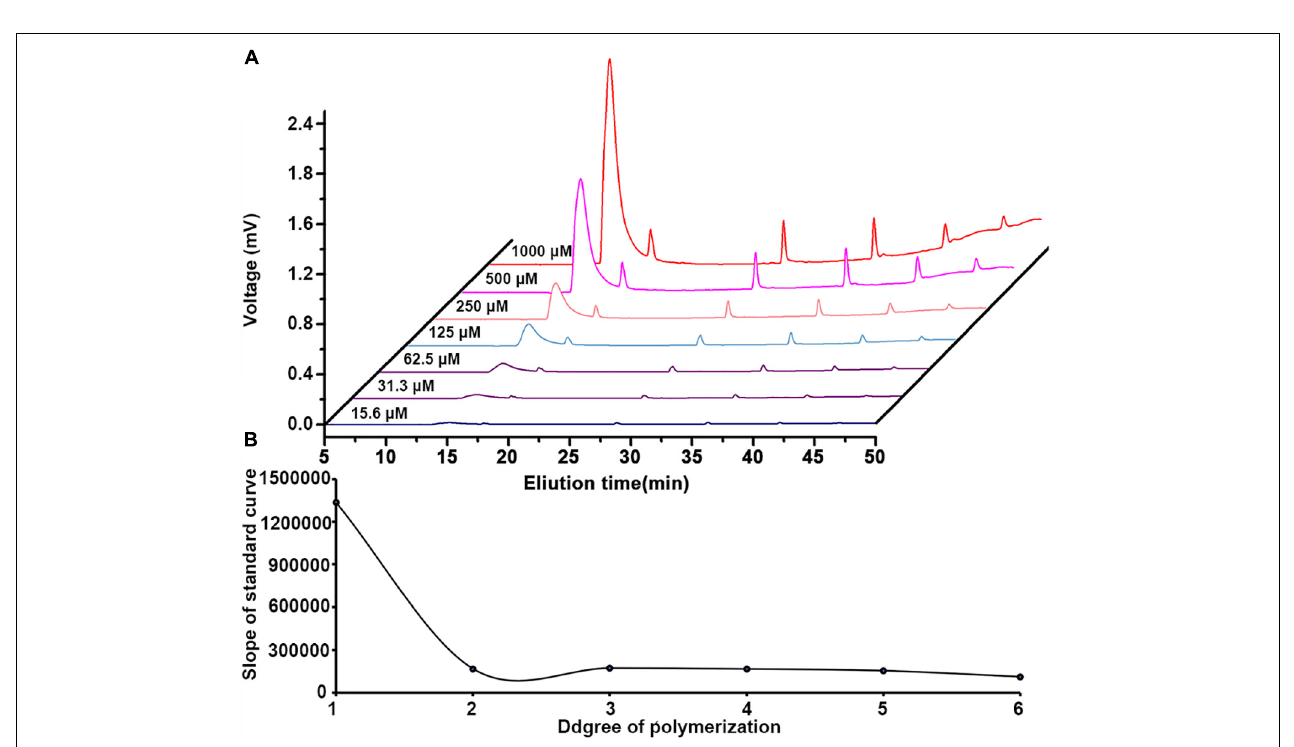
FIGURE 5 | (A) HILIC-FLR elution curves of oligogalacturonide standards (DP1-6) at different concentrations. (B) Comparison of the slope of GalA standard curve.